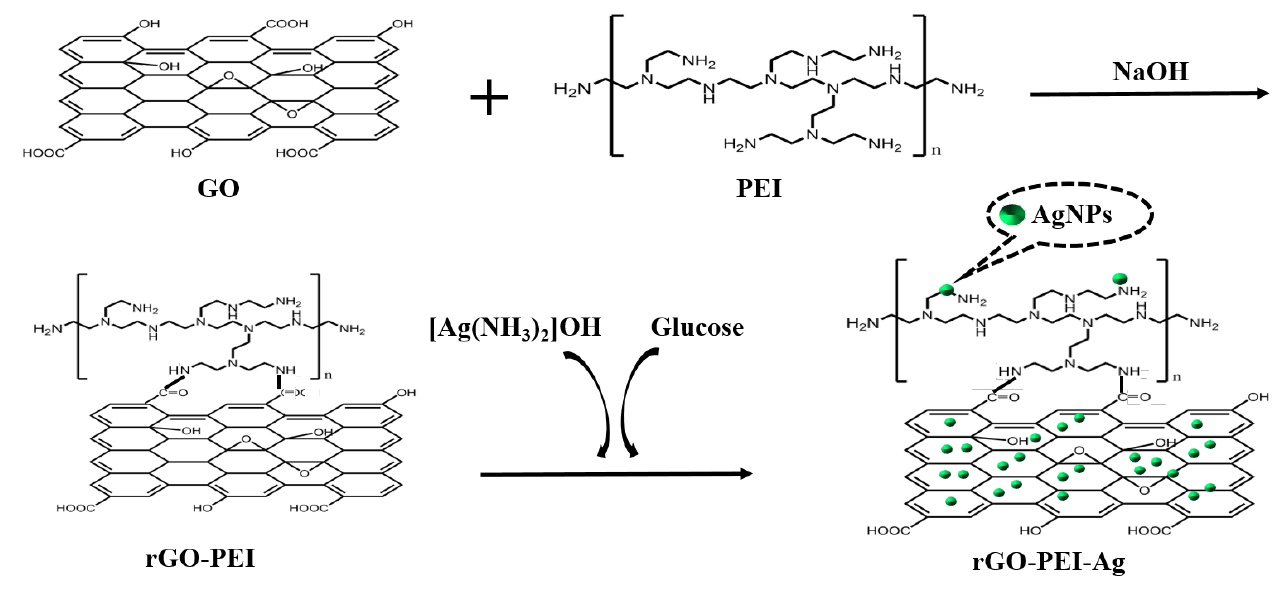
Figure 1. Preparation of rGO-PEI-Ag nanomaterials.